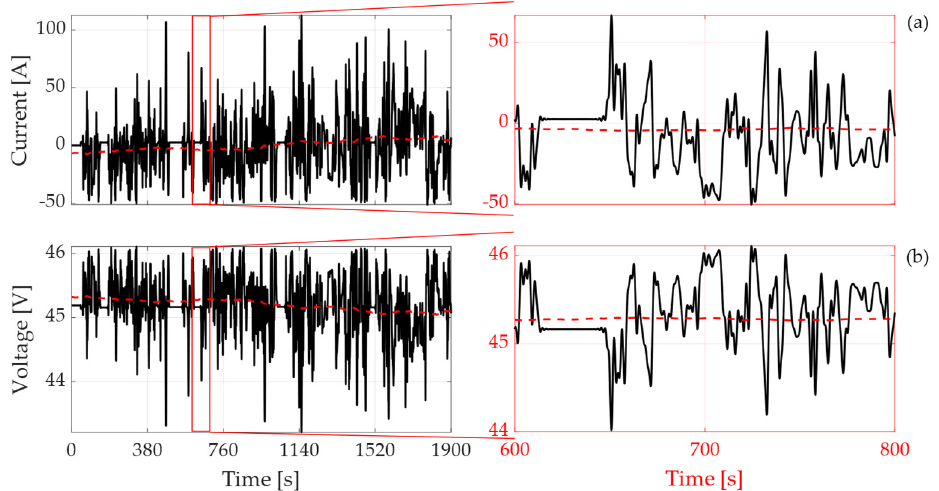
Figure 10. Testing dataset B: ( a ) current (solid black) and averaged current (dashed red), ( b ) voltage (solid black) and averaged voltage (dashed